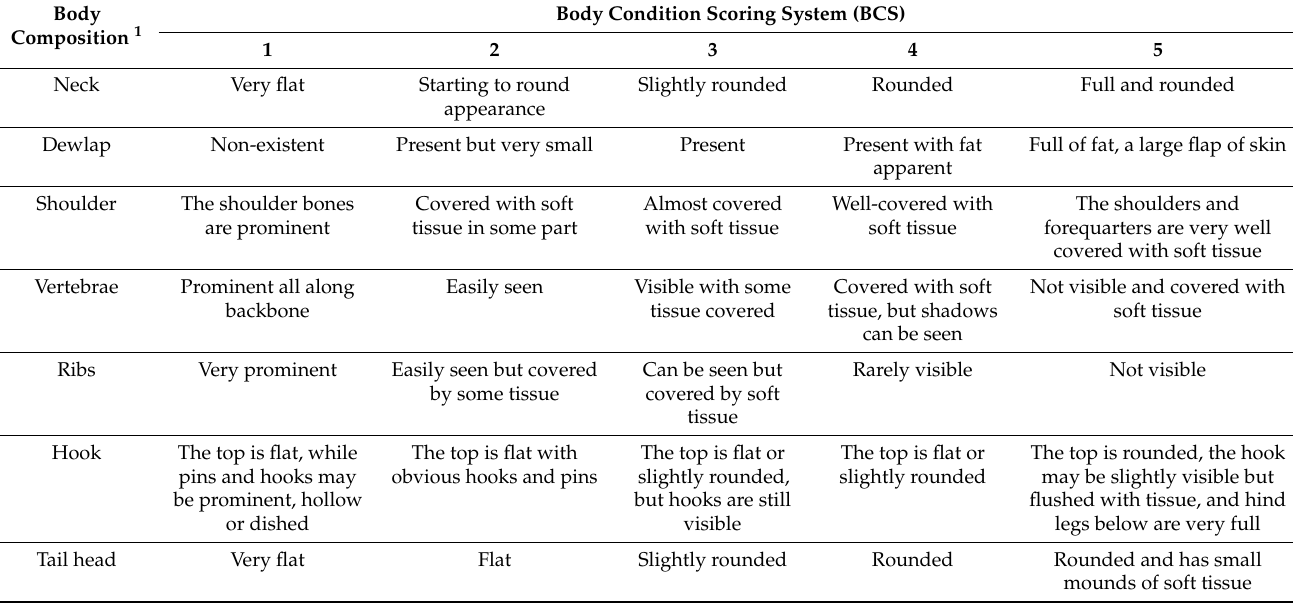
Table 1. The scoring criteria for body composition of the bantengs in